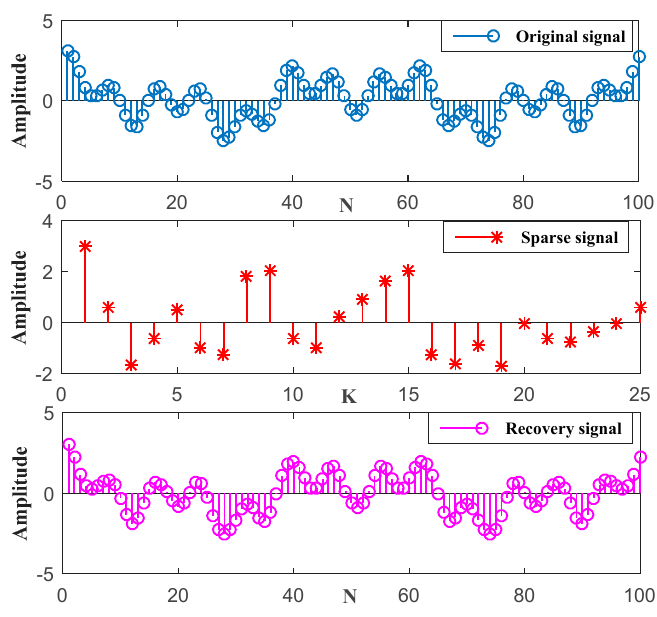
Figure 12. Original signal, sparse signal, and recovery signal.